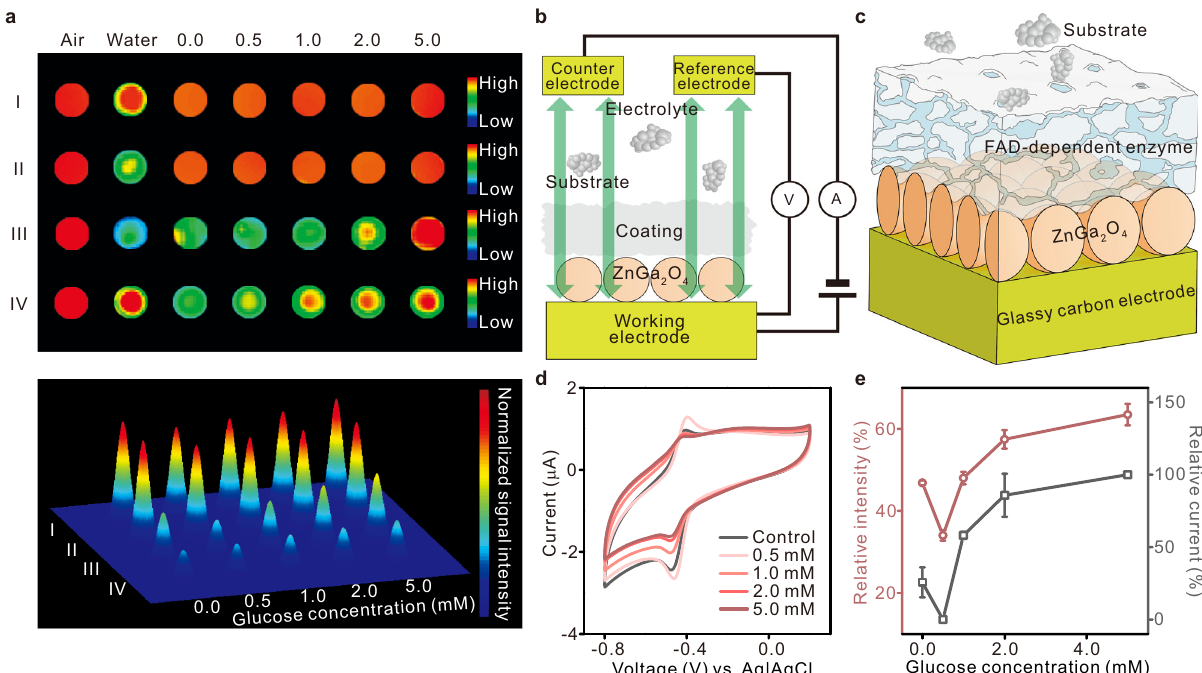
Fig. 2 Afterglow imaging and quanti fi cation of electron transfer. a Afterglow image (upper) and readout signal intensity mapping image (lower) of persistent luminescence nanoparticles (I, Sr 2 MgSi 2 O 7 :Eu,Dy, color scale: 2.50 × 10 7 – 1.44 × 10 9 ; II, SrAl 2 O 4 :Eu,Dy, color scale: 2.50 × 10 7 – 1.44 × 10 9 ; III, ZnGa 2 O 4 :Cr, color scale: 2.00 × 10 7 – 1.10 × 10 8 ; IV, Zn 3 (PO 4 ) 2 :Mn 2 + ,Ga 3 + , color scale: 1.25 × 10 7 – 2.00 × 10 10 ) under different conditions (air, water, and GOD solution with 0.0 – 5.0 mM glucose) at 1.0 s after white light excitation. b Schematic of the three-electrode electrochemical set-up used. c Schematic of the ZnGa 2 O 4 /GOD coating on a glassy carbon electrode in glucose-containing electrolyte. d Typical voltammograms showing oxidation and reduction peaks of phosphate-buffered solution (PBS) solution of glucose at various concentrations (0.0 – 5.0 mM) on a fresh ZnGa 2 O 4 /GOD-coated electrode. e Extracted relative afterglow intensity mean values (red circles) from the afterglow images a and extracted reduction peak current mean values (gray squares) from the voltammograms versus the concentration of glucose ( n = 3 independent electrodes). Error bars in all graphs represent the s.d. of the mean